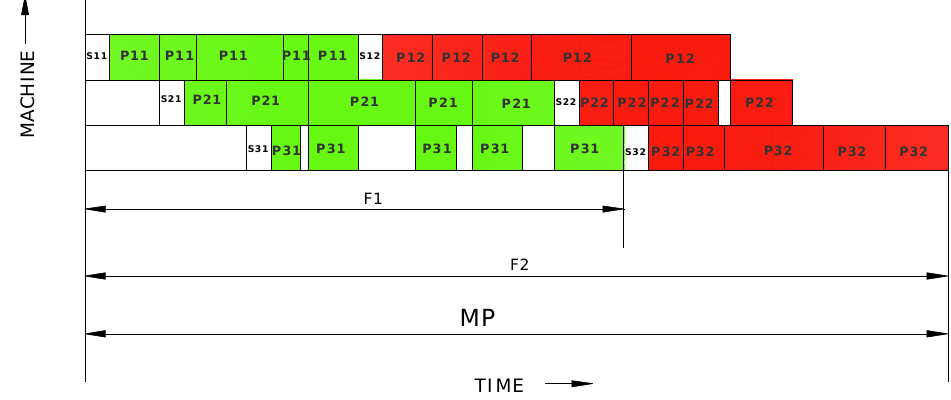
Fig.2 -An example showing 5 sublots, two Jobs being processed through three